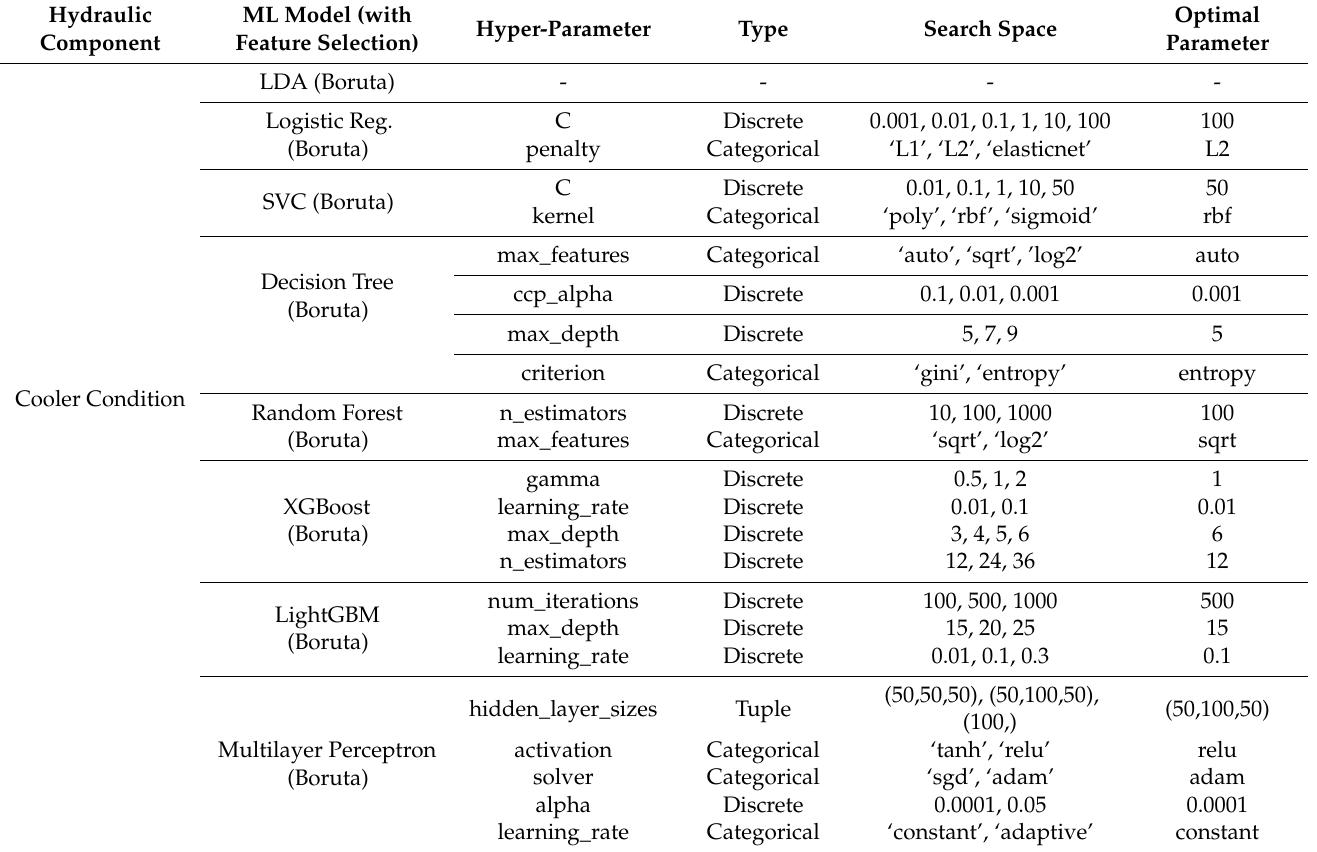
Table 5. Hyper-parameter configuration space and optimal parameter under cooler